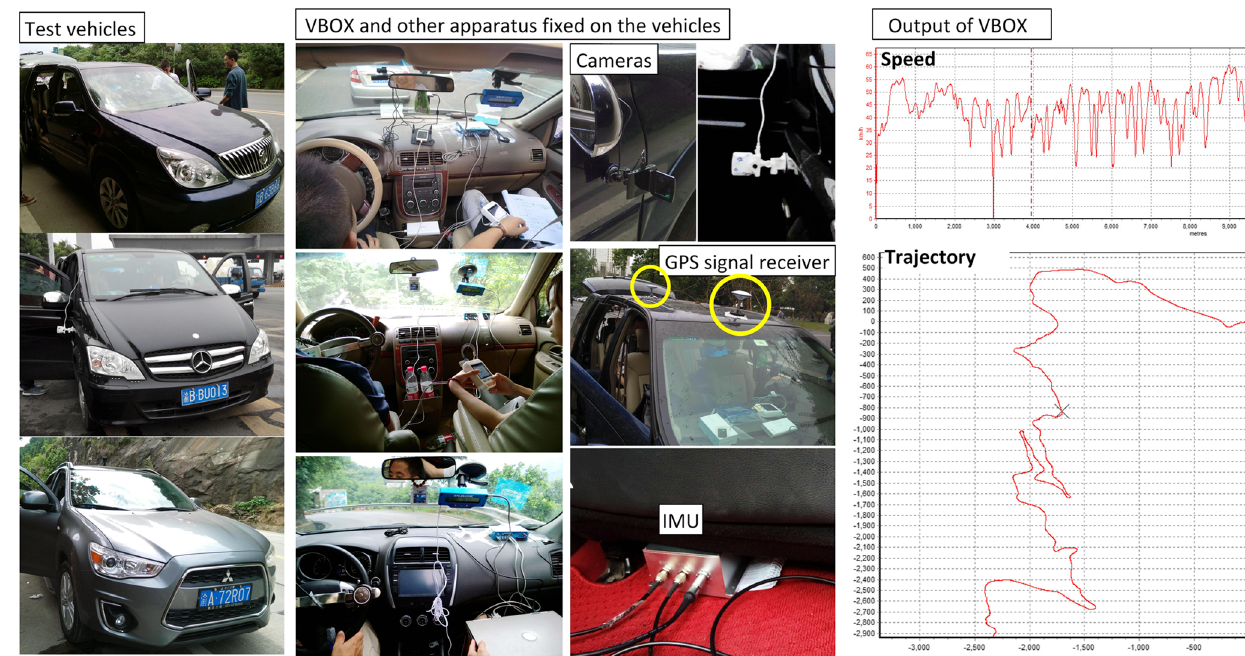
Fig. 3 Driving test using passenger cars under natural driving